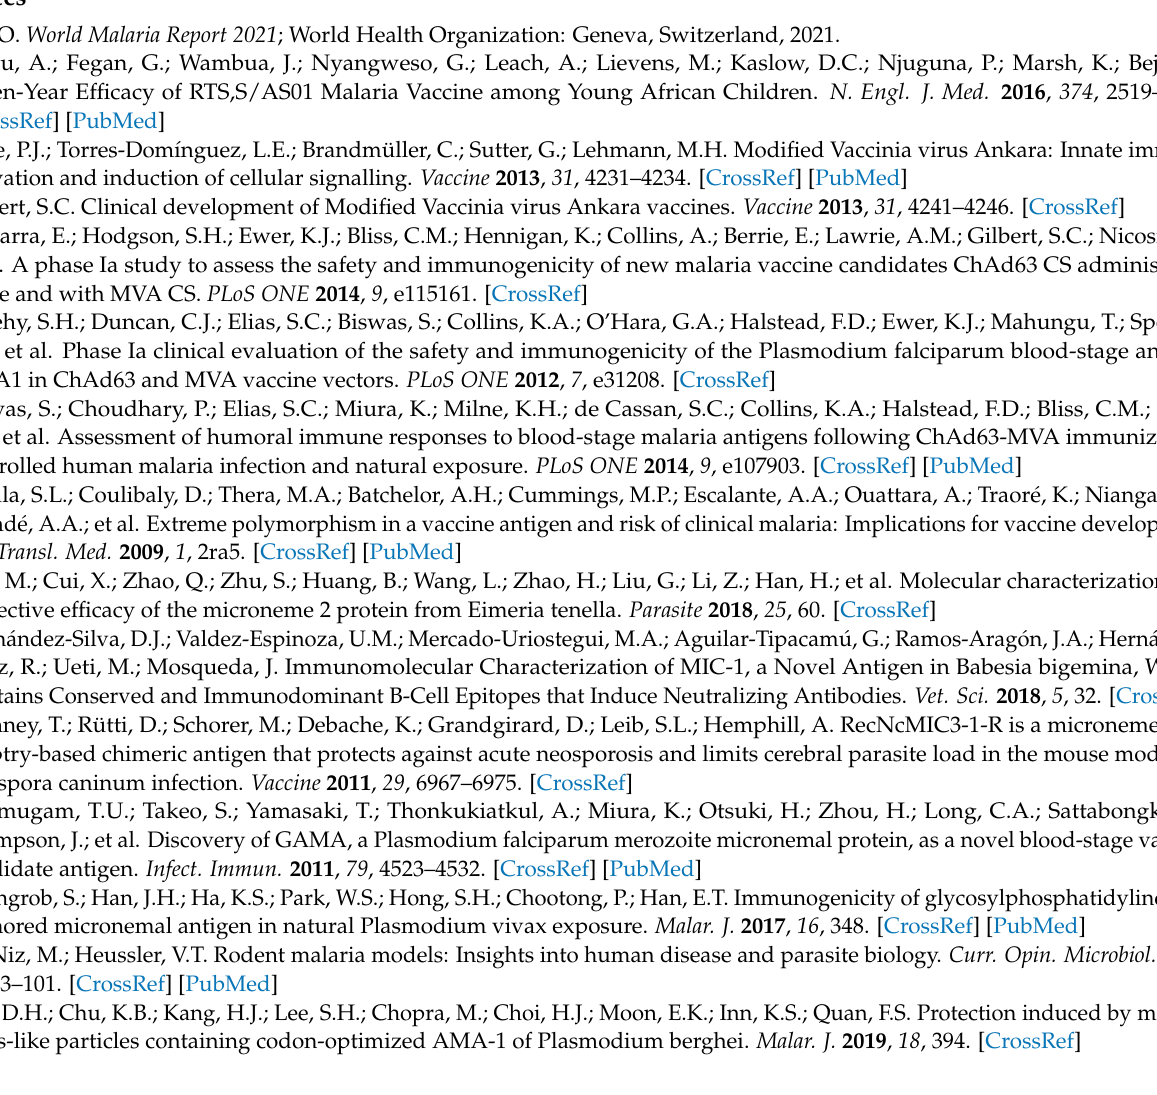
Figure A3. The gating strategy for CD4 + and CD8 + T cells. Lymphocytes were gated as indicated to analyze the frequencies of CD4 + and CD8 + T cells by flow cytometry.